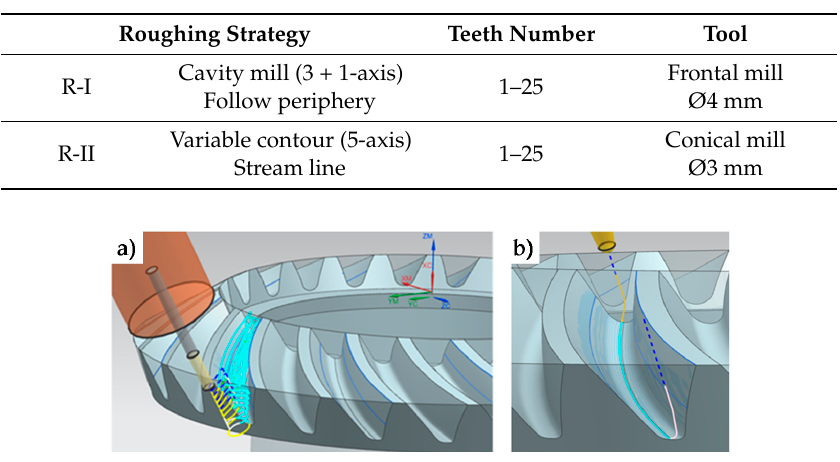
Figure 2. R-I ( a ) and R-II ( b ) roughing strategies.